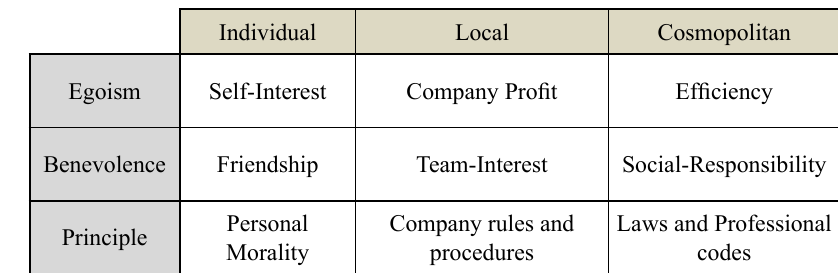
Fig. 1. Theoretical strata of ethical climate (Victor, Cullen 1987,